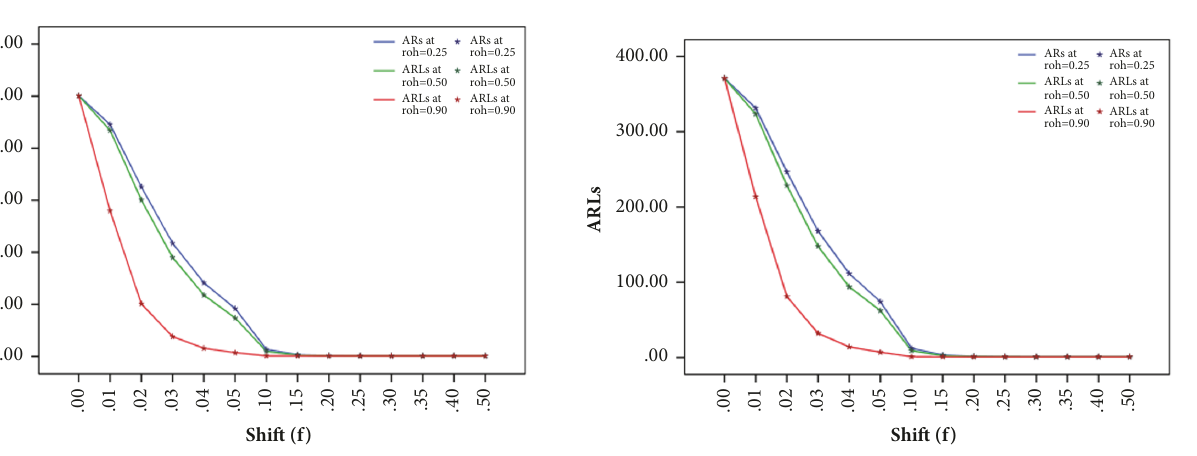
Figure 8: ARLs for proposed repetitive EWMA-RSS control chart using Khan et al. [8] ratio estimator, when 𝑟 𝑜 = 500 at 𝜆 = 0.2.